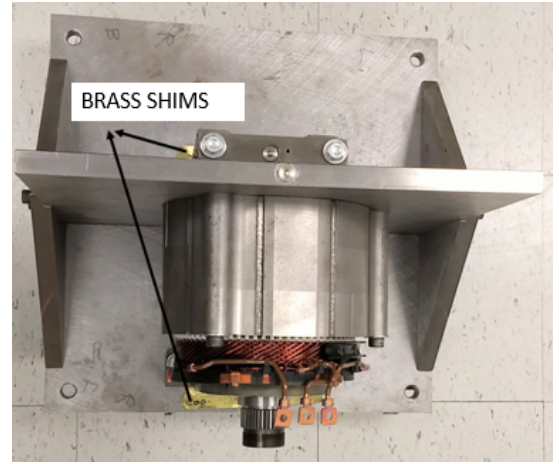
Figure 10. Fault implementation